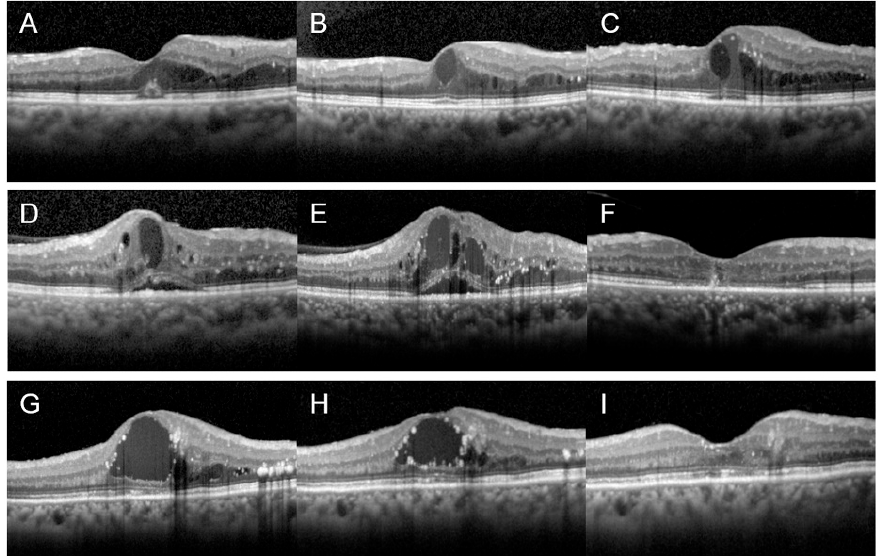
Figure 2. Representative cases of patients with decreased renal function. ( A – C ) A case of a 59-year-old woman with moderate CKD who was maintained on IVBI therapy for DME in the left eye. Her estimated GFR was 35.1 mL/min/1.73 m 2 . She was administered three doses of IVBIs; however, her macular edema worsened ( B ) compared with the initial visit ( A ). Bevacizumab injection therapy was continued; however, 4 weeks after further treatment with bevacizumab, the retinal edema was not improved ( C ), and BCVA in the left eye was maintained at 20/70. ( D – F ) A case of a 52-year-old women with severe CKD who was switched to aflibercept. Her estimated GFR was 29.5 mL/min/1.73 m 2 . She was administered three doses of IVBIs; however, her macular edema worsened ( E ) compared with the initial visit ( D ). After 8 weeks of aflibercept switching treatment, macular edema was reduced and BCVA also improved from 20/70 to 20/50 ( F ). ( G – I ) A case of a 75-year-old woman with severe CKD who was switched to dexamethasone implant. Her estimated GFR was 17 mL/min/1.73 m 2 . After three doses of IVBI, macular edema slightly reduced ( H ) compared with the initial visit ( G ); however, intraretinal fluid was still observed. Four weeks after a single administration of dexamethasone implant, macular edema reduced ( I ) and BCVA also improved from 20/70 to